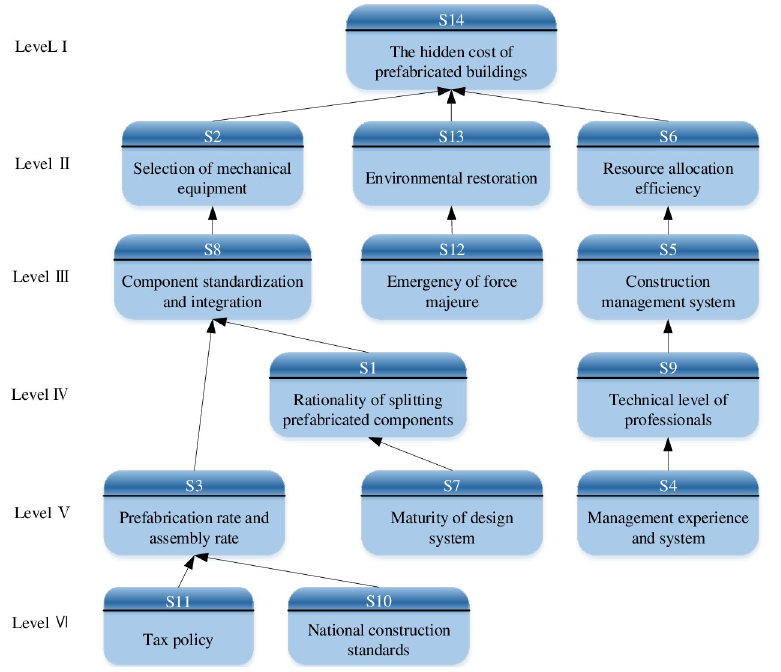
Fig 3. Hierarchical structure